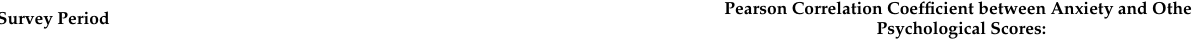
Table 8. Correlation between anxiety and other psychological scores (psychological burden, per- ceived infectability, and germ aversion) according to vaccination status and intention in all three survey